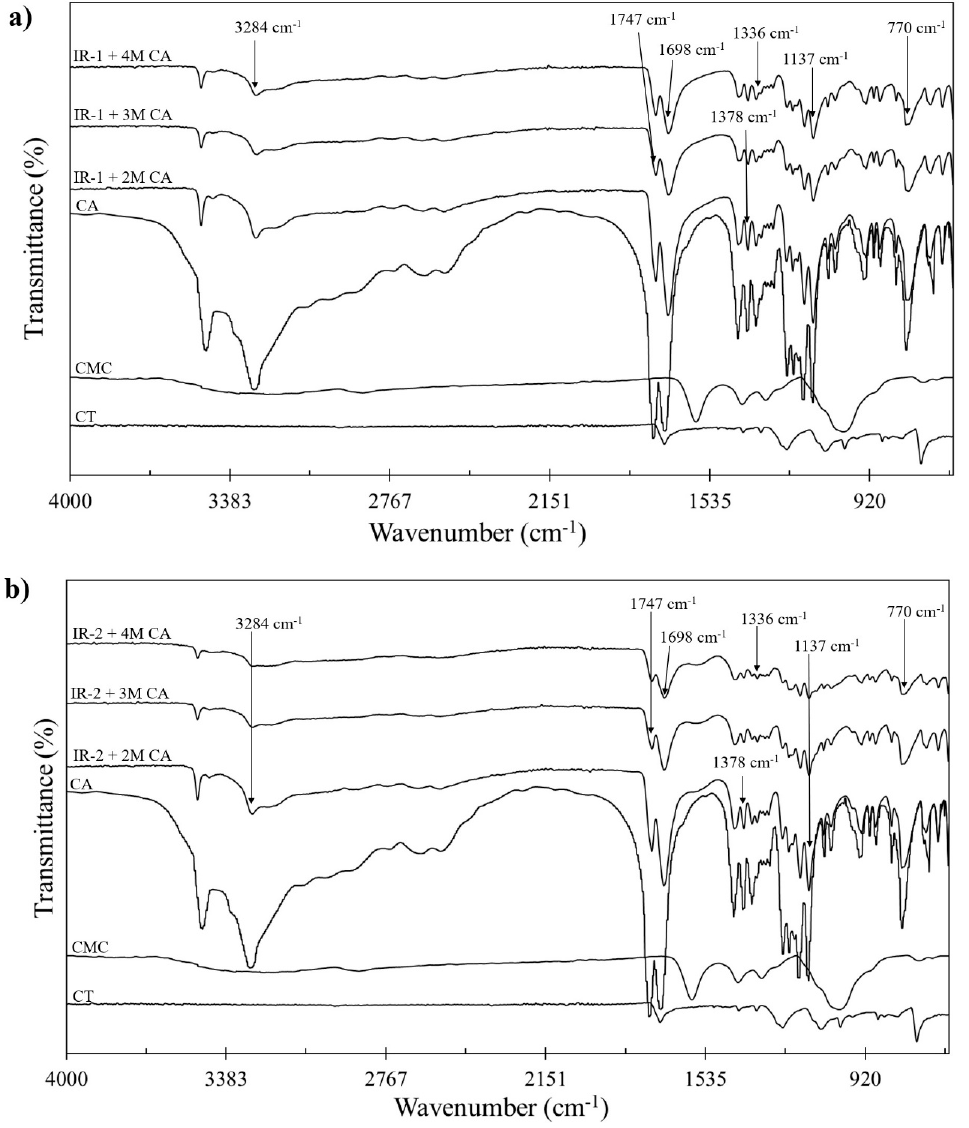
Figure 2. FTIR spectrum comparison between ( a ) single-coated CMC cross-linked with 2M–4M CA, ( b ) double-coated CMC cross-linked with 2M–4M CA.